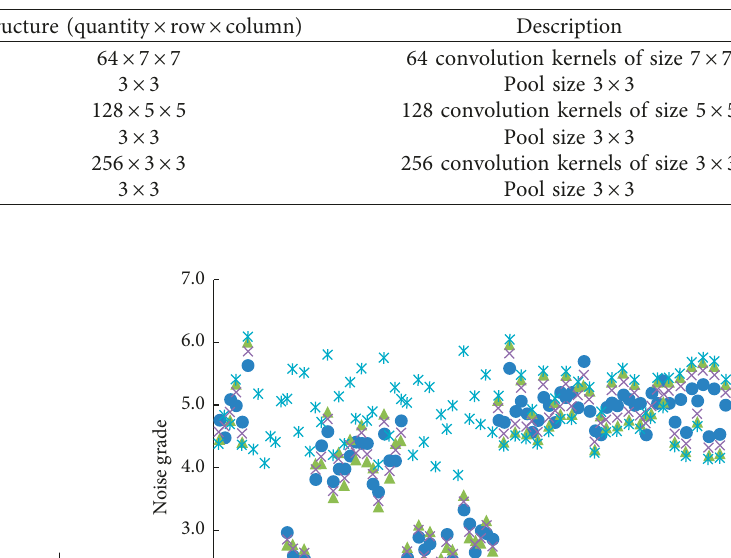
Table 2: Structure of convolutional neural network evaluation model.